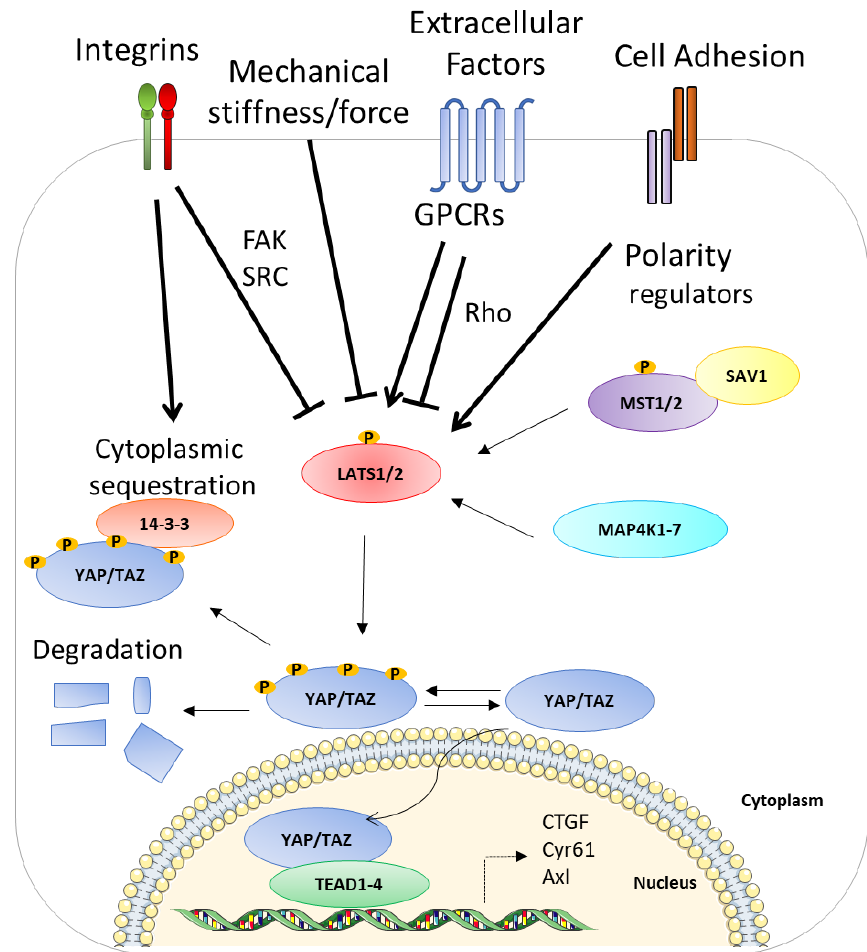
Figure 1. A schematic representation of the ON and OFF state of the Hippo pathway. The activation of the Hippo pathway leads to YAP phosphorylation and its subsequent sequestration and degradation. By contrast, the inactivation of the Hippo pathway allows YAP to enter the nucleus in order to interact with TEAD1–4 and activate their target genes. See text for details. The membrane image and DNA double helix are adapted from Servier Medical Art (smart.servier.com (accessed on 4 May